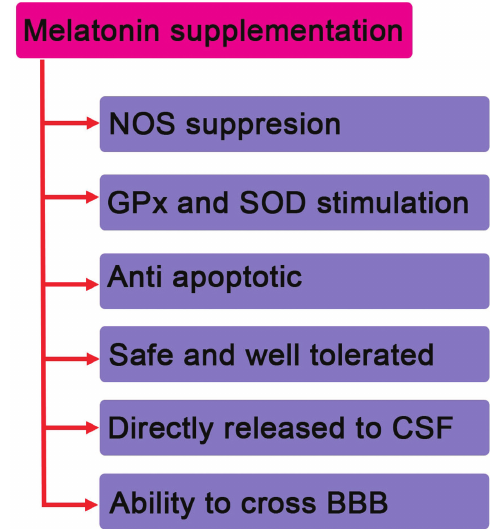
Fig. 2 Possible effects of melatonin supplementation. Abbreviations: BBB, blood-brain barrier; CSF, cerebrospinal fl uid; GPx, glutathione peroxidase; NOS, nitric oxide synthase; SOD, superoxide